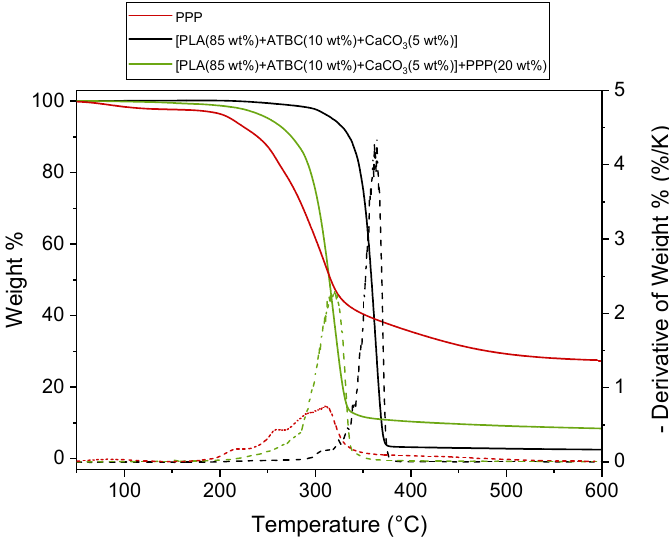
Figure 1. Thermogravimetric curves of the potato pulp powder (PPP), the poly(lactic acid) (PLA)-based matrix andbiocomposite [PLA (85 wt%) + acetyl tributyl citrate (ATBC; 10 wt%) + CaCO 3 (5 wt%)] + potato pulp powder (PPP; 20 wt%) at 10 K/min under nitrogen flow. The dotted lines are the derivatives of the weight % curves.